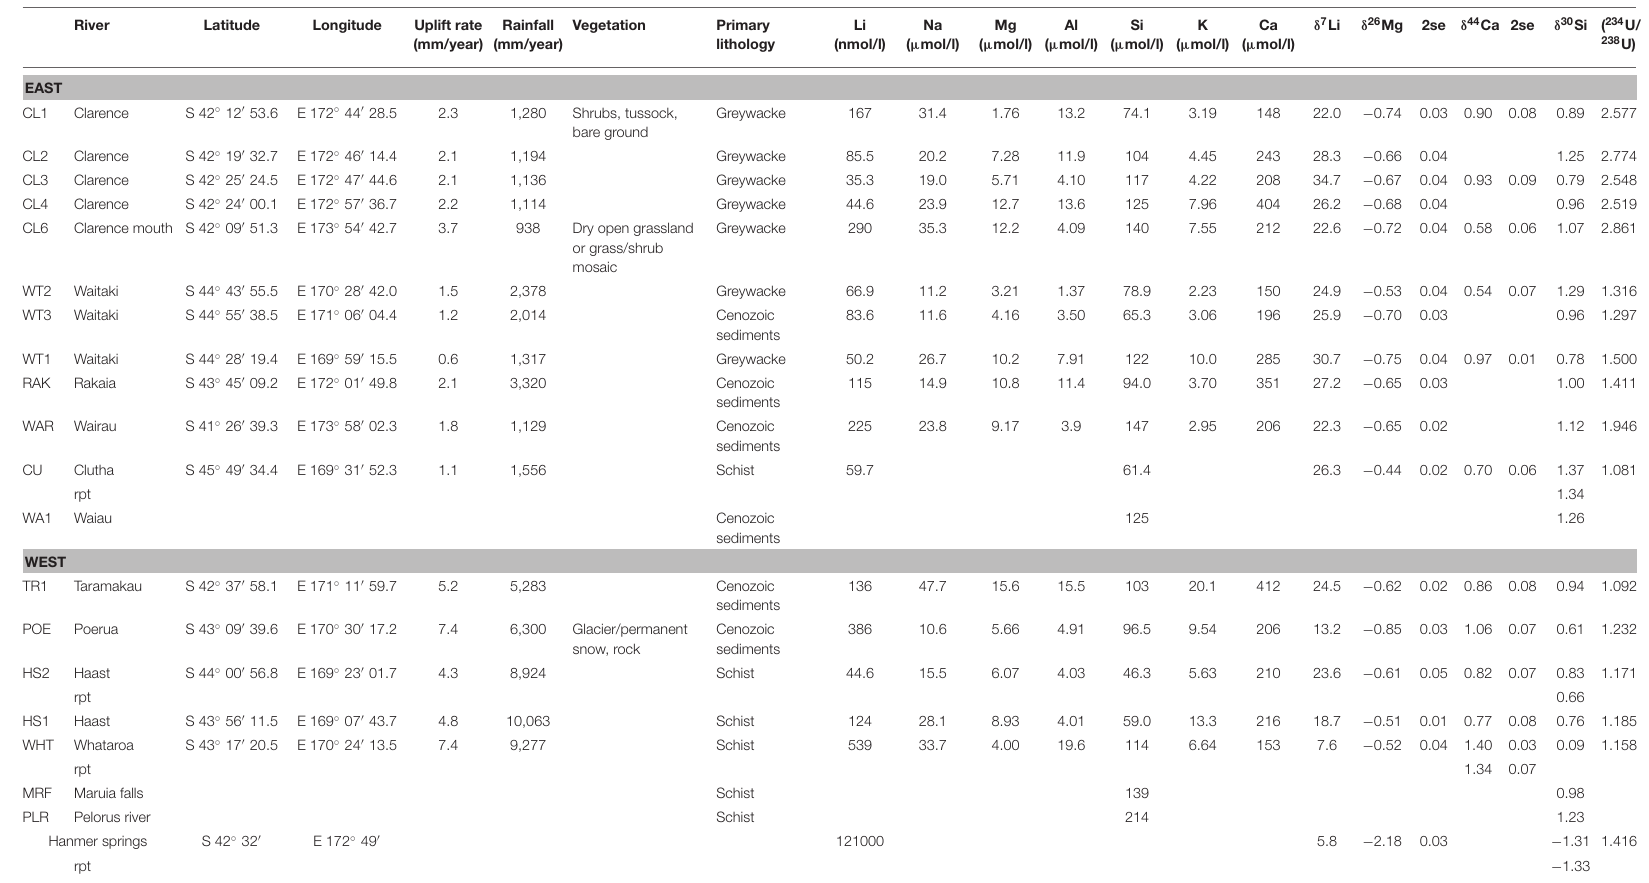
TABLE 1 | Elemental concentrations (from Pogge von Strandmann and Henderson, 2015) and isotope ratios for the New Zealand rivers. River Latitude